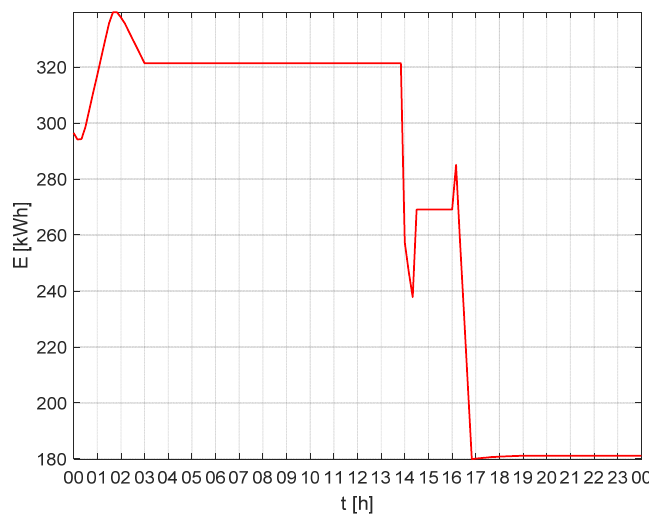
Figure 22. Results of the simulation of the operation of the private network with the BESS with real characteristics for the power margin PM set as a step function between − 400 and 400 kW; change of energy accumulated in the BESS over time.